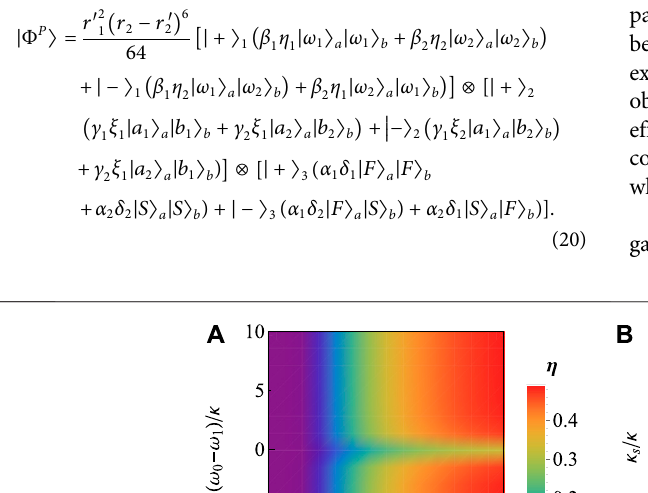
FIGURE 3 | (A) The ef fi ciency of high- fi delity hyperparallel CPF gate vs . g/ hyperparallel CPF gate vs . g/